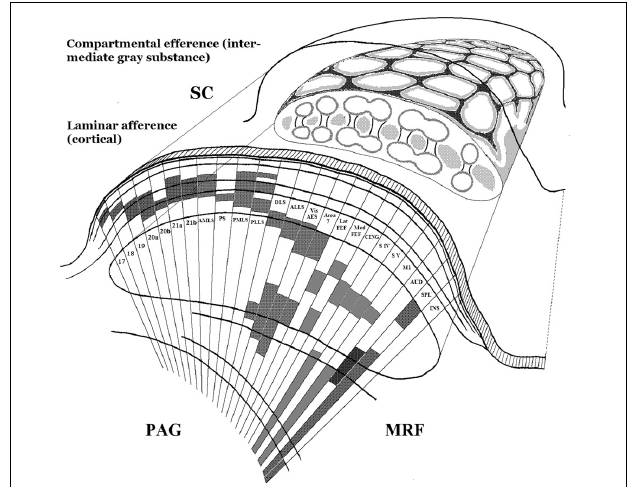
FIGURE 3 | Schematic depiction of two principal design features of the anatomical organization of the superior colliculus. Lower left: The cortex-like segregation, by laminar depth in the colliculus, of collicular afferents from many and diverse cortical and subcortical sources. Here only cortical sources are illustrated. Each source typically projects through the full mediolateral extent of the colliculus, but is here shown only as a narrow sector in which its laminar depth is marked by shading. The drawing is a simplified adaptation of results by Harting and colleagues in the cat (Harting et al., 1992), patterned after their summary Figure 27. Upper right: A cartoon of the compartmental organization of the collicular intermediate gray substance, based on histochemical and connectional studies in rat and cat (Harting et al., 1992, 1997; Chevalier and Mana, 2000). The upper surface of the composite drawing is patterned after Figure 6 of Chevalier and Mana (2000), and its cut face is loosely patterned after Figure 26 of Harting et al. (1992). Note that this part of the figure combines patterns from rat and cat, and is not anatomically veridical. It is only intended to convey the honeycomb-like tessellation of the collicular intermediate gray substance, by means of which distinct input-output “channels” are concatenated within a shared sensori-motor topography. See further the studies just cited, as well as Deniau et al., 2007 and Redgrave et al., 1992. SC, superior colliculus; PAG, periaqueductal gray matter; MRF, midbrain reticular